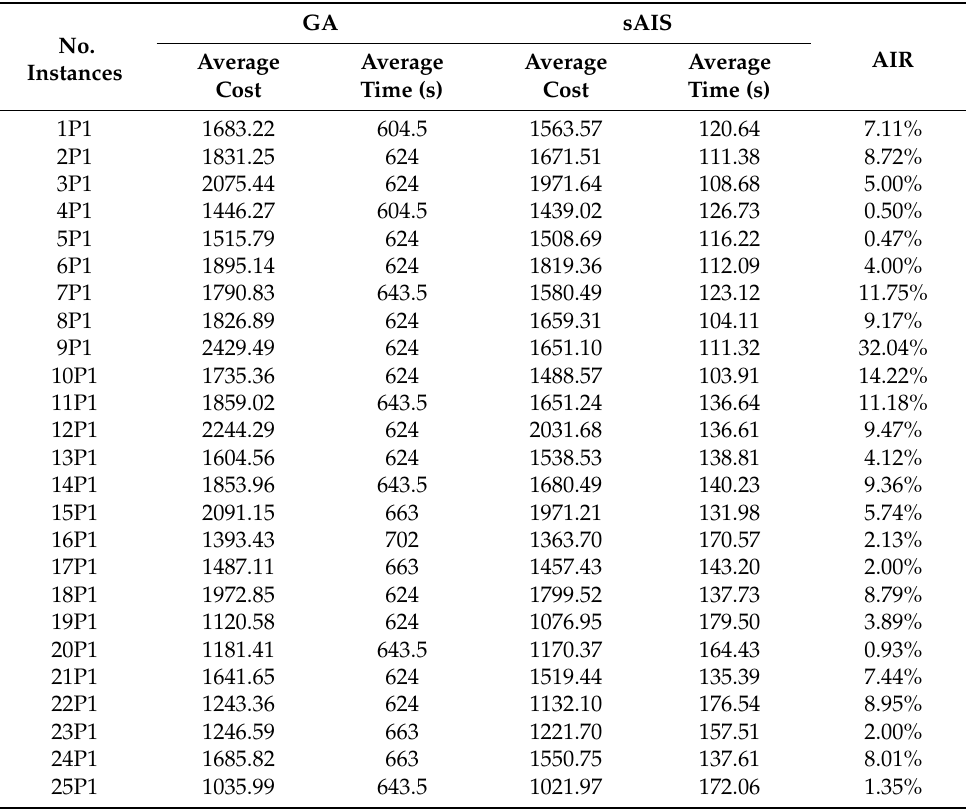
Table 1. Performance comparisons between sAIS and